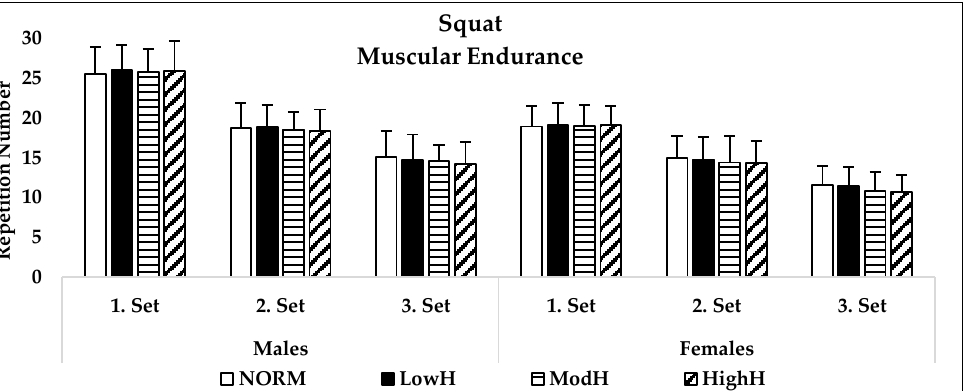
Figure 2. Mean (SD) bench press and squat strength (1-RM) performance. NORM: Normoxia (900 m); LowH: Low dose of hypoxia (2000 m); ModH: moderate dose of hypoxia (3000 m); HighH: high dose of hypoxia (4000 m).